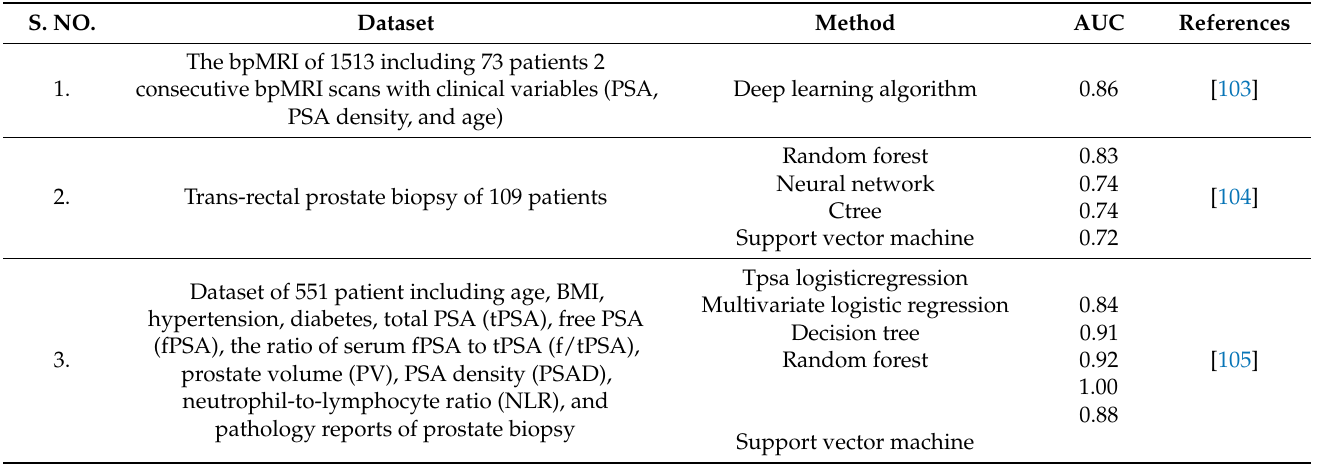
Table 4. Summary of dataset used in several studies with their respective performance on PC detection. S. NO.